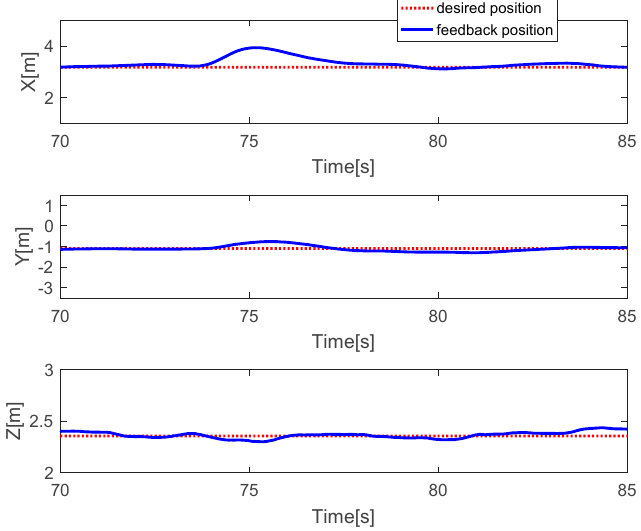
Figure 7. Horizontal and vertical movement of the quadcopter.